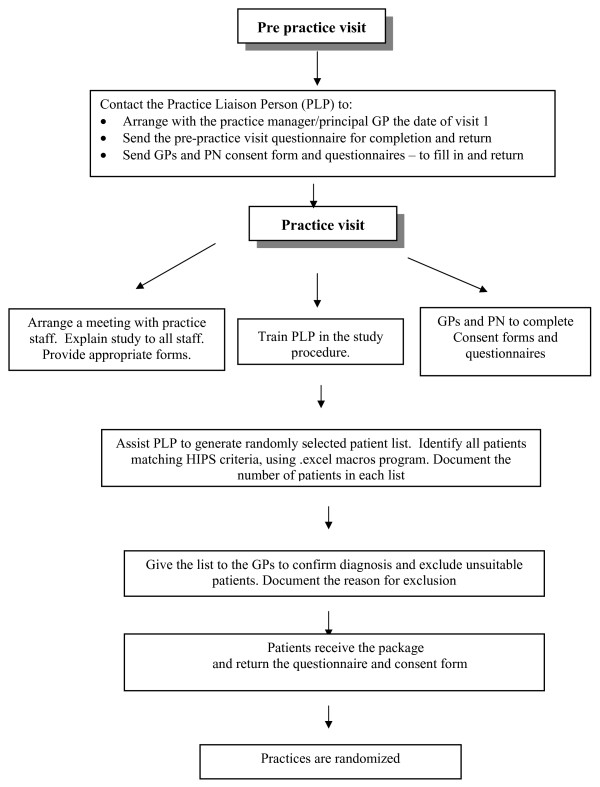
HIPS Recruitment Flowchart.